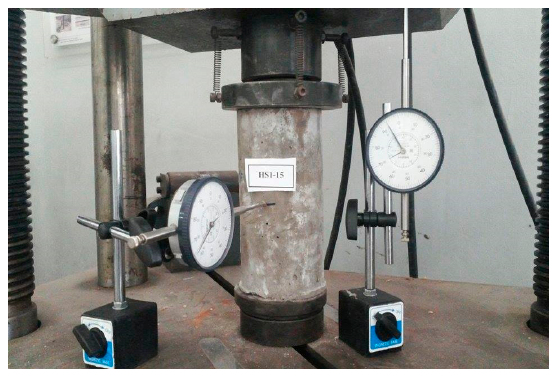
Figure 7. Experiment of Poisson’s ratio and elastic modulus.